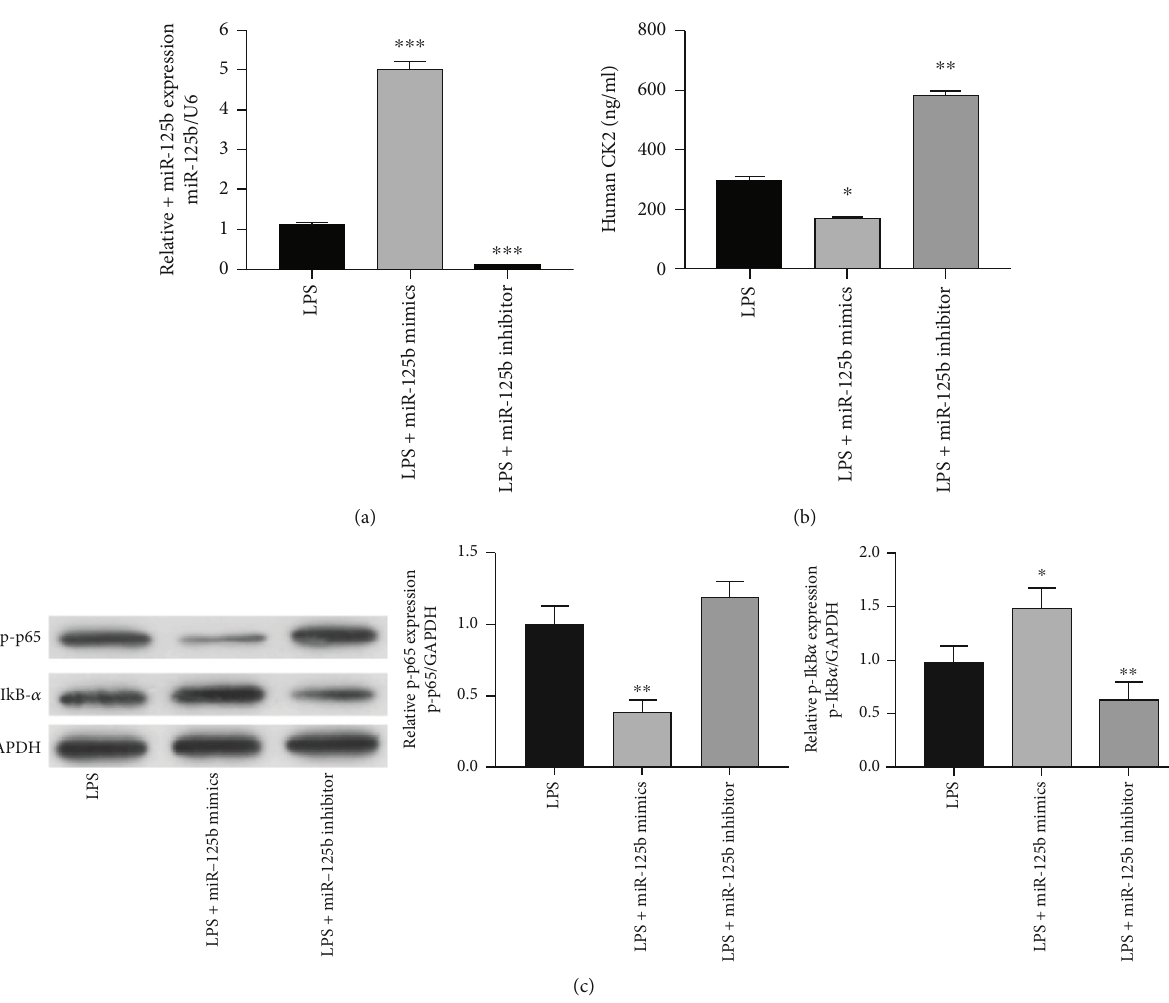
Figure 3: miR-125b suppresses NF- κ B activation through CK2 in LPS-treated MH7A cells. MH7A cells were transfected with miR-125b mimics or miR-125b inhibitor and then treated with 1 μ g/mL LPS for 24h. (a) The mRNA expression of miR-125b was evaluated via qRT-PCR. (b) Human CK2 concentration in the cultured supernatant was measured by using an ELISA assay. (c) The protein expression of NF- κ B pathway members including p-p65 and p-IkB- α was evaluated via western blot. N = 3 , ∗ p < 0 : 05 , ∗∗ p < 0 : 01 , and ∗∗∗ p < 0 : 001